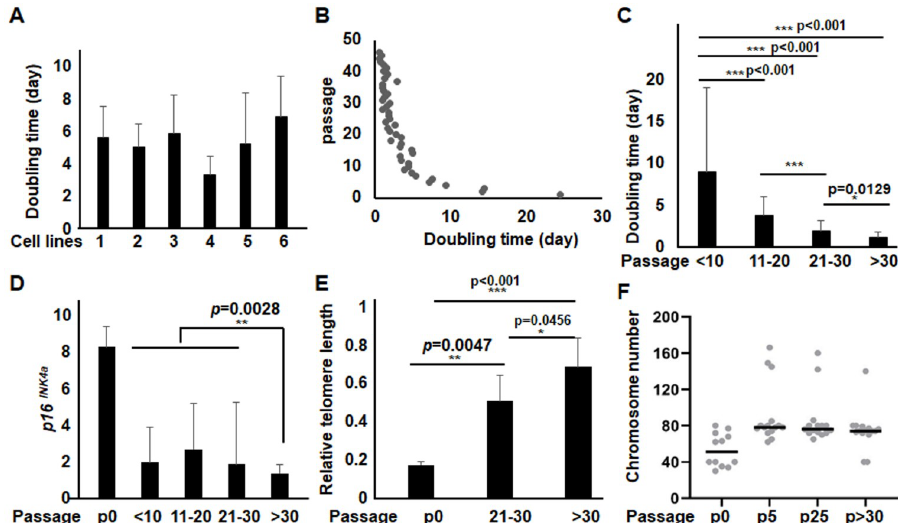
Fig 2. The growth properties of long-term cultured keratinocytes derived in KSFM-Ca 2+ medium. The average doubling time of representative cell lines at (A) the early passages, and (B) at different passages was calculated based on the cell numbers plated, harvested and days in culture. (C) Comparison of the average doubling time +/-SD of cells at < 10, 11–20, 21–30 and > 30 passages. Cells of medium and high passages grew significantly faster than those of low passages. The primary murine keratinocytes grown in DK-SFM (p0) and the KSFM-Ca 2+ cells at different passages were examined for (D) p16 INK4a mRNA, (E) The relative telomere length, in comparison to levels in mESCs, set as 1, and (F) chromosome numbers and results represent data from 12–15 metaphase cells